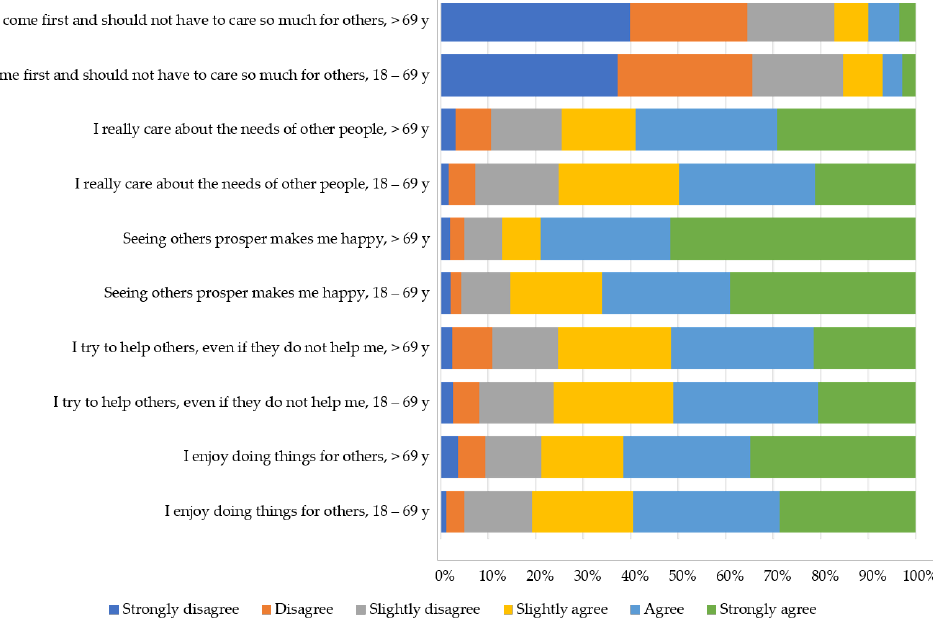
Figure 1. Differences in response patterns to single items of the altruism scoring system by survey participant age groups 18–69 years ( n = 1169) and 70 years and above ( n = 257), respectively. Abbreviation: y, years.